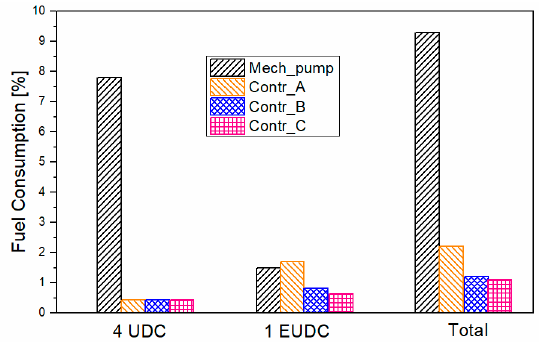
Figure 19. Fuel consumption reduction achieved with the use of the controller during the NEDC cycle.